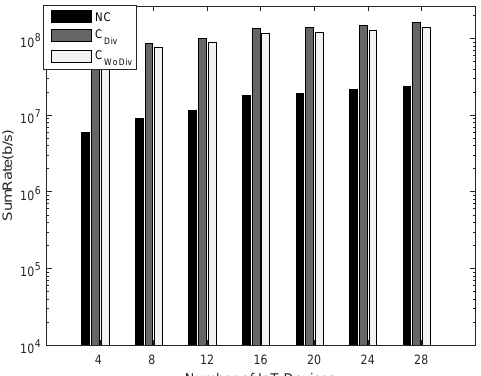
Figure 5. Sum-rate with respect to different number of total devices, with 10 relays and minimum device data rate of 128